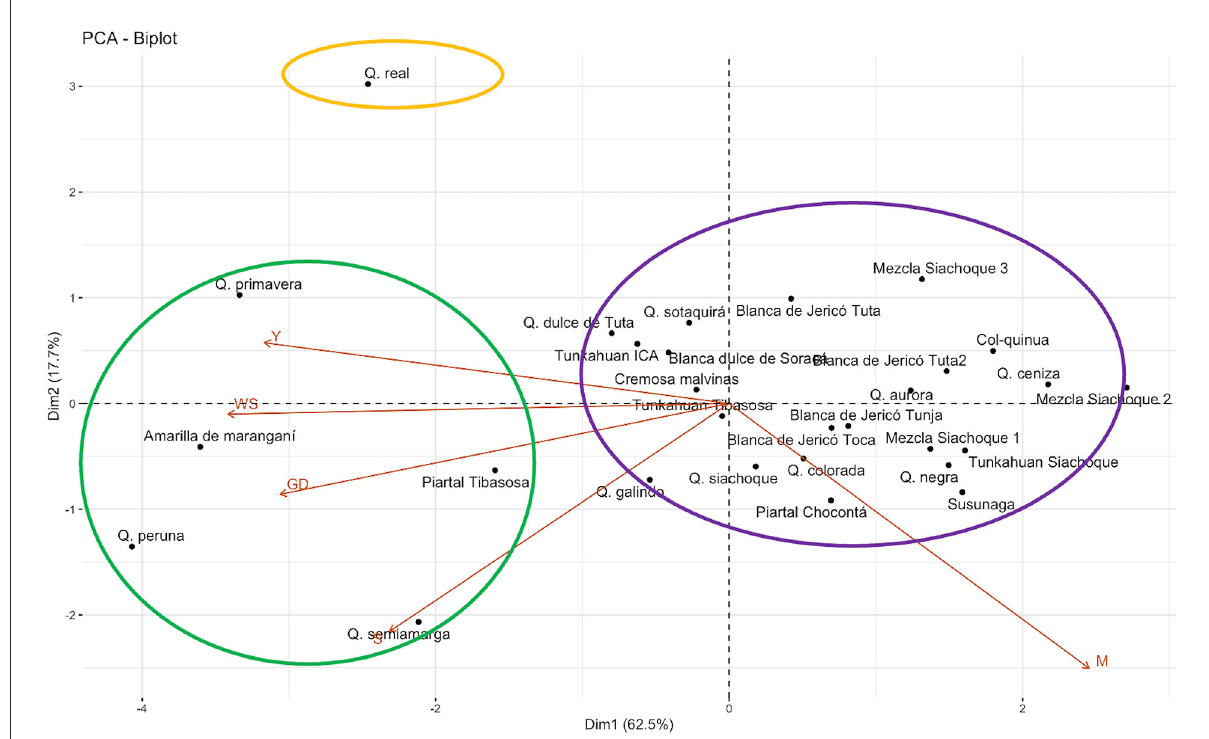
FIGURE2 Biplot of the analysis of main components. The variables that contributed to yield were weight and diameter of the seeds. Footnote: GD grain diameter, WS weight of 1,000 seeds, Y yield, M days to physiological maturity, S concentration of triterpene saponins.